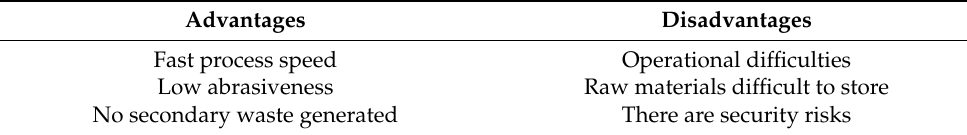
Table 3. The advantages and disadvantages of dry ice